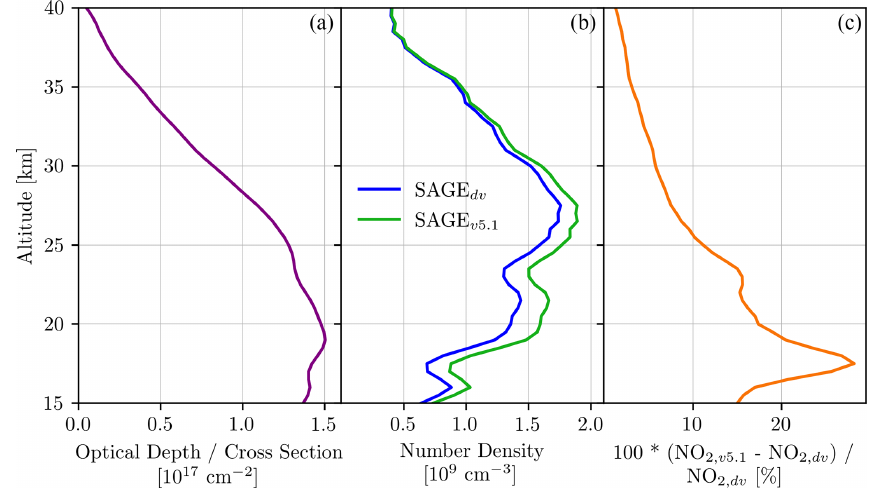
Figure 6. (a) NO 2 optical depth. (b) NO 2 number density for both the diurnally varying and SAGE v5.1 retrievals. (c) Percent difference between the two number density profiles. Calculated for SAGE III/ISS event